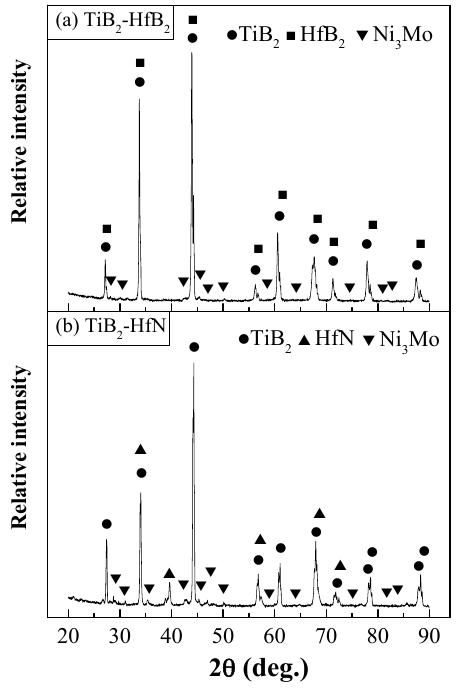
Figure 1. XRD patterns of TiB 2 -HfB 2 and TiB 2 -HfN ceramic tool materials.